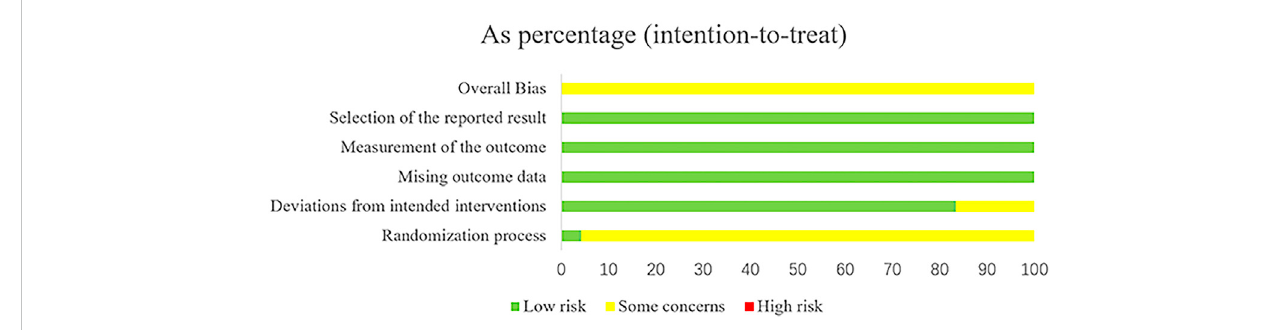
FIGURE 3 The results for the evaluation of the selected articles using ROB2.0.